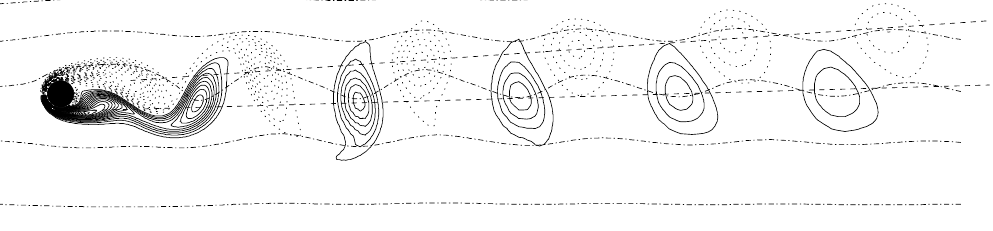
Figure 10. Instantaneous snapshot of azimuthal vorticity ( for negative, for positive values) and Stokes streamfunction ( ) for the flow around a torus at Γ = 0.1 and Re = 1000. The dashed lines ( ) connect the centres of the vortices of the same sign.